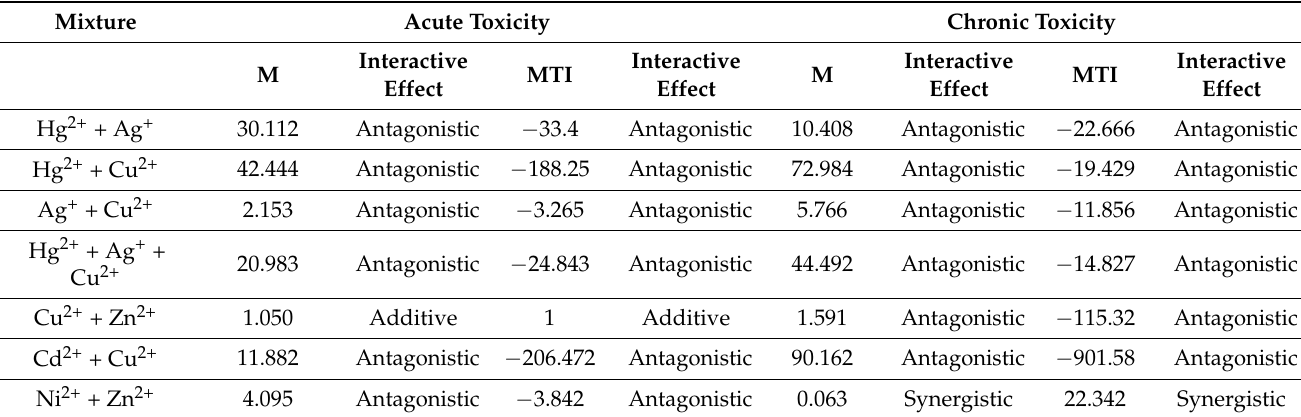
Table 8. TU and MTI approaches to determine the interaction of two and three combined heavy metal effects over Acute (30 min) and Chronic (6 h) on Photobacterium sp.NAA-MIE.